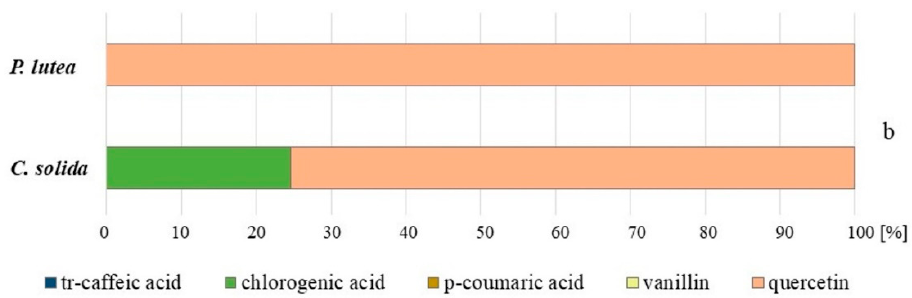
Figure 2. Isoquinoline alkaloids ( a ) and phenolic compounds ( b ) proportions in underground parts of P. lutea and C. solida .